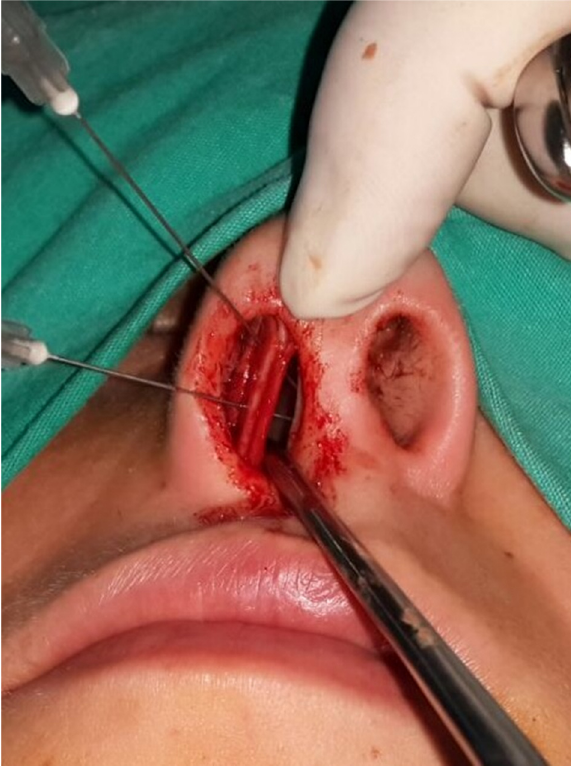
Figure 4 Application of caudal septal extension graft (CSEG).